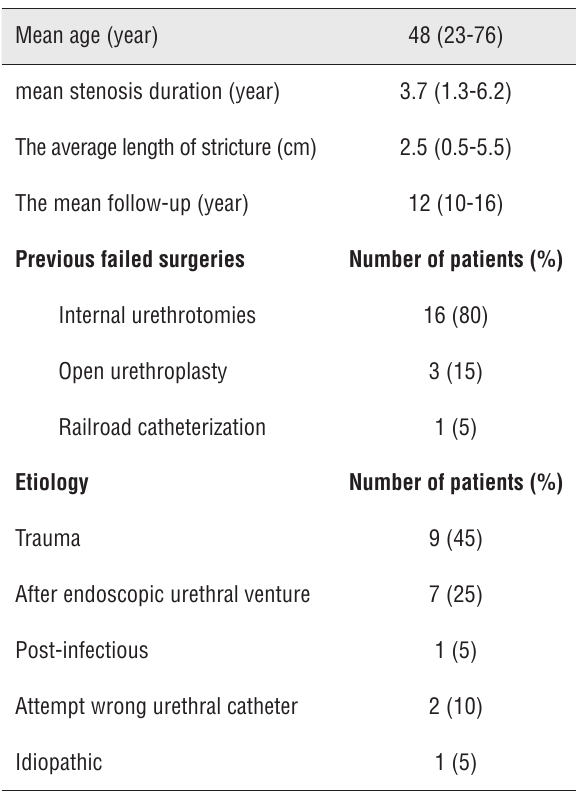
Table 1 - Patients' characteristics and causes of urethral